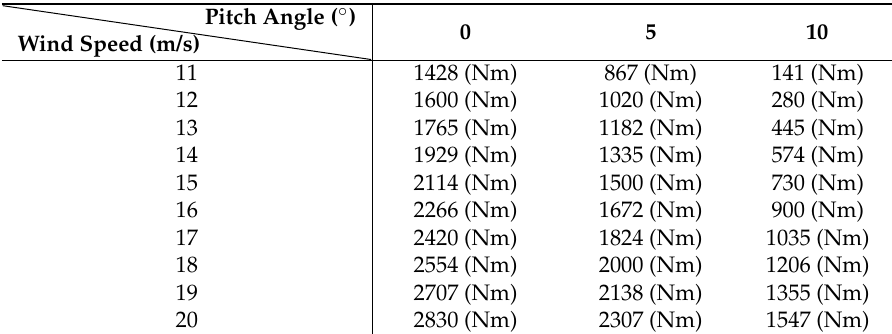
Table 2. The disturbance torque under different pitch angles and wind speed.